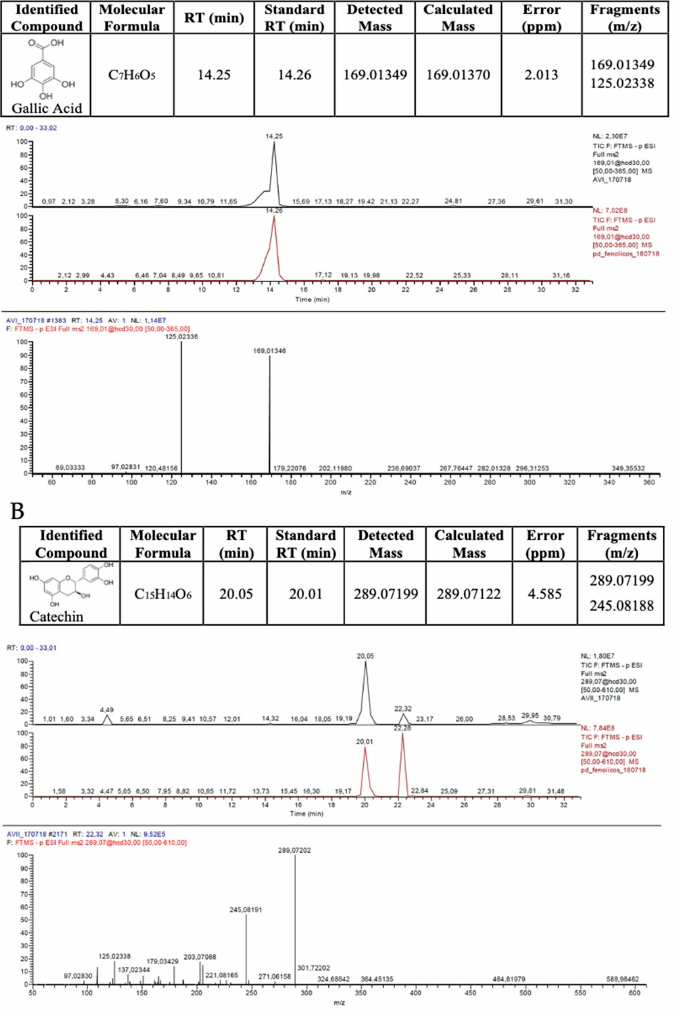
Figure 2. Qualitative high-efficiency liquid chromatography coupled to high-resolution mass spec- trometry of the ethanolic extract of pequi bark. Representative chromatographic profiles of compo- nents detected in six of seven samples: ( A ) gallic acid; ( B ) catechin. RT—retention